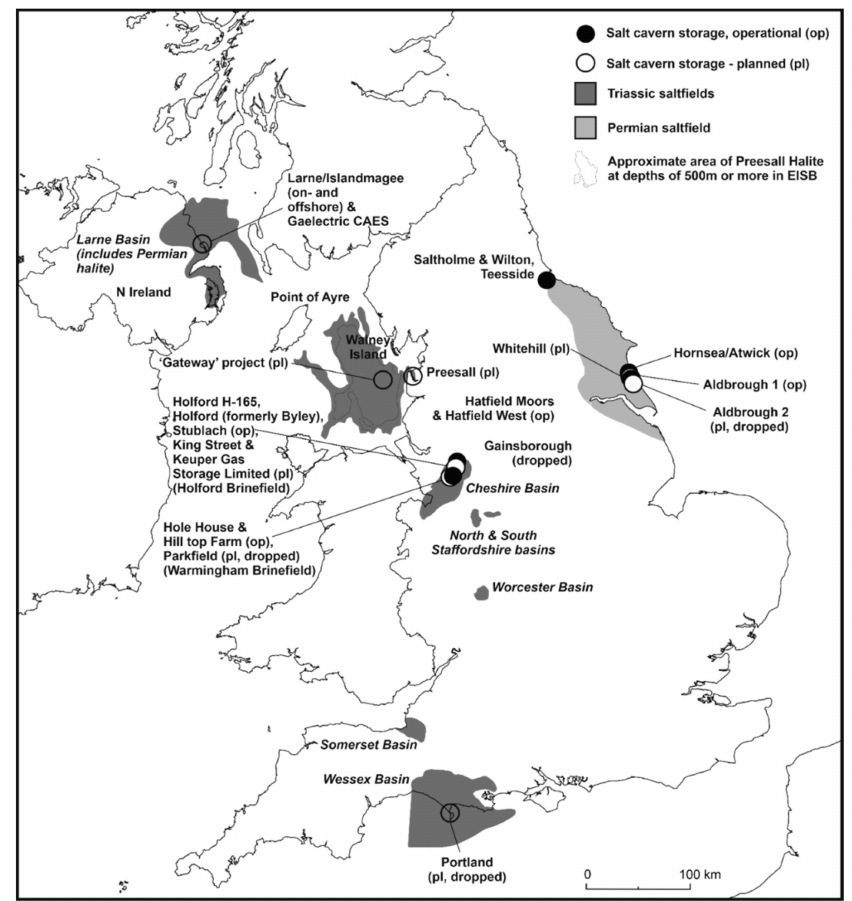
Figure 1. General outcrop map of the main halite basins studied onshore England and offshore East Irish Sea. Note area indicated in the East Irish Sea is that of the Triassic Preesall Halite at depths investigated (500–1500 m). Refer also S2, Table S1 for details on UGS